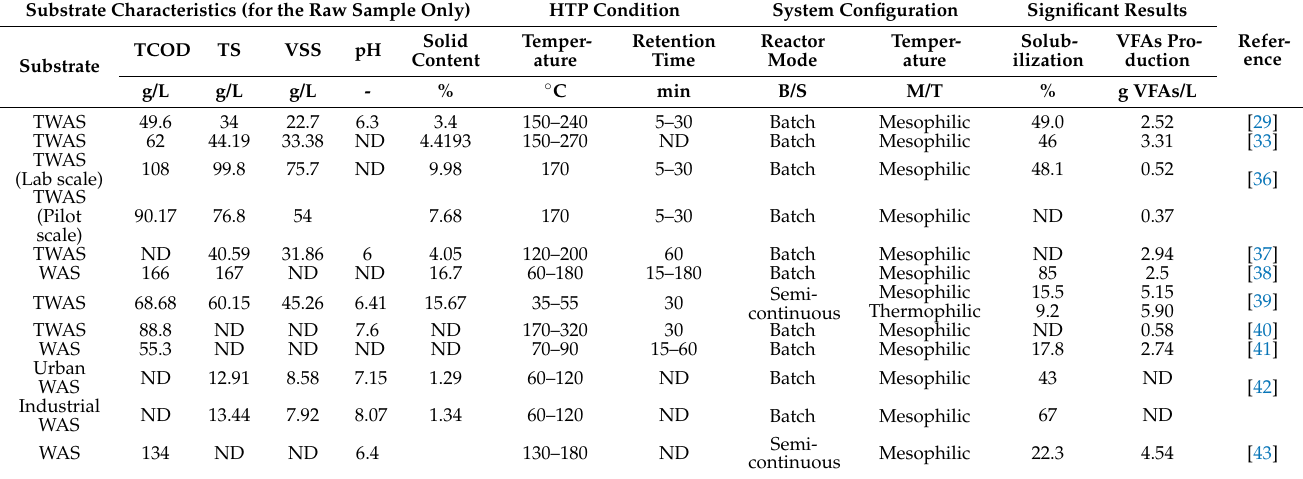
Table 1. Studies on hydrothermal pretreatment of TWAS for VFAs